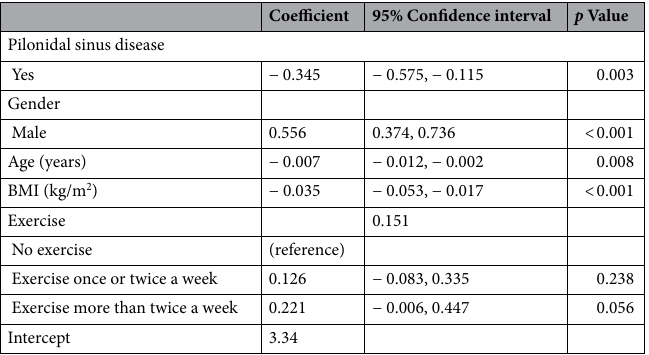
Table 3. Linear regression of the natural logarithm of sweat response on PSD, gender, age, BMI and exercise. BMI = body mass